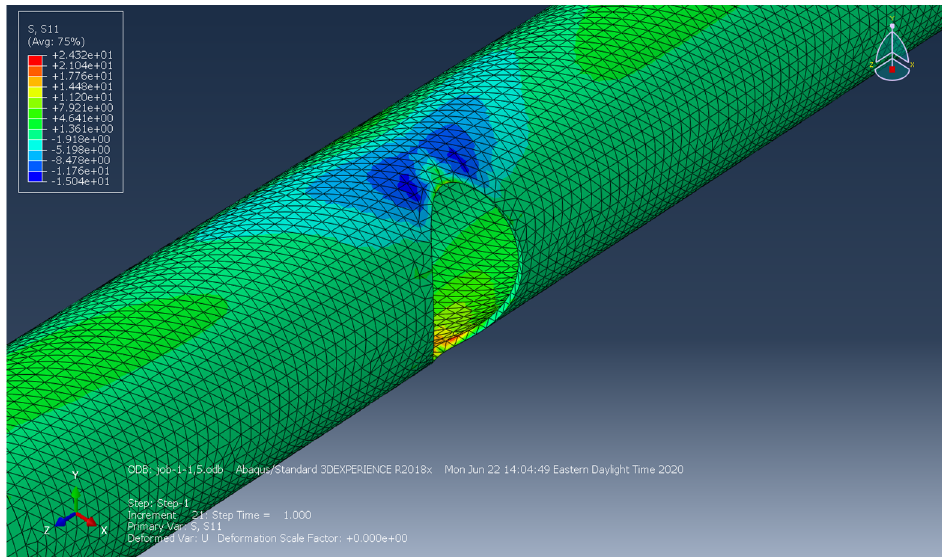
Figure 22. Aspect ratio 1-1.5 in transverse (X) direction.